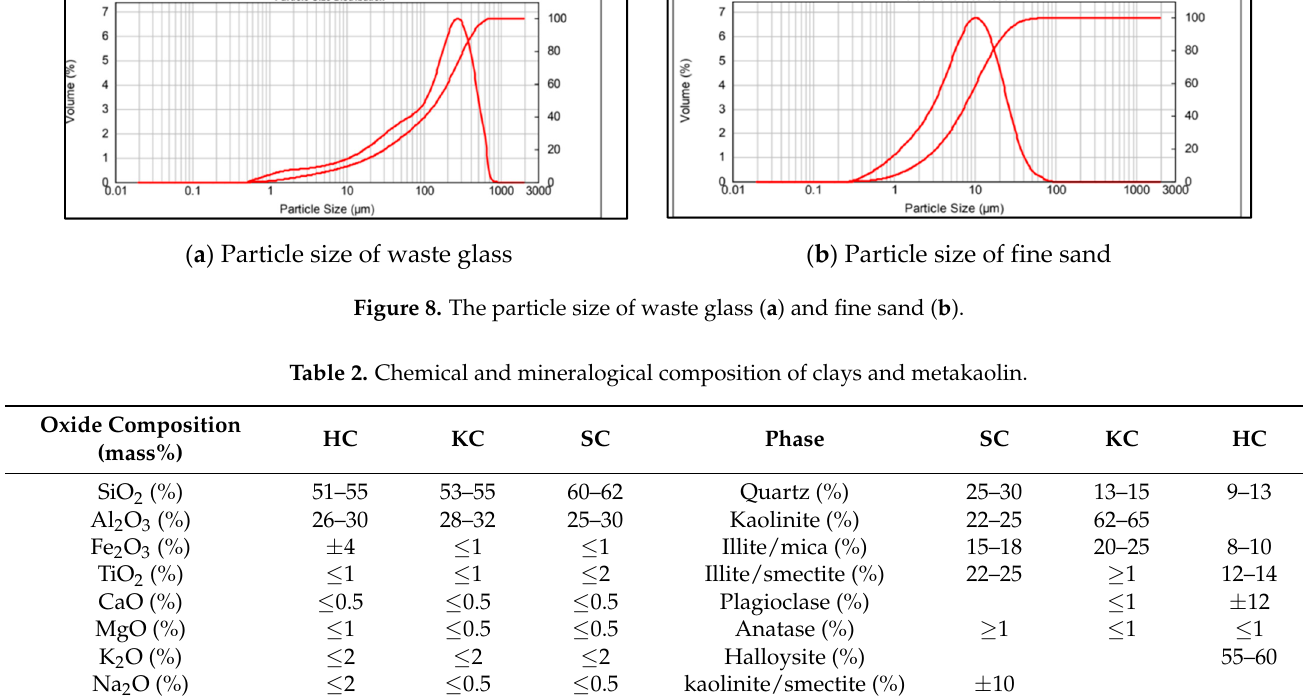
Table 2. Chemical and mineralogical composition of clays and metakaolin .